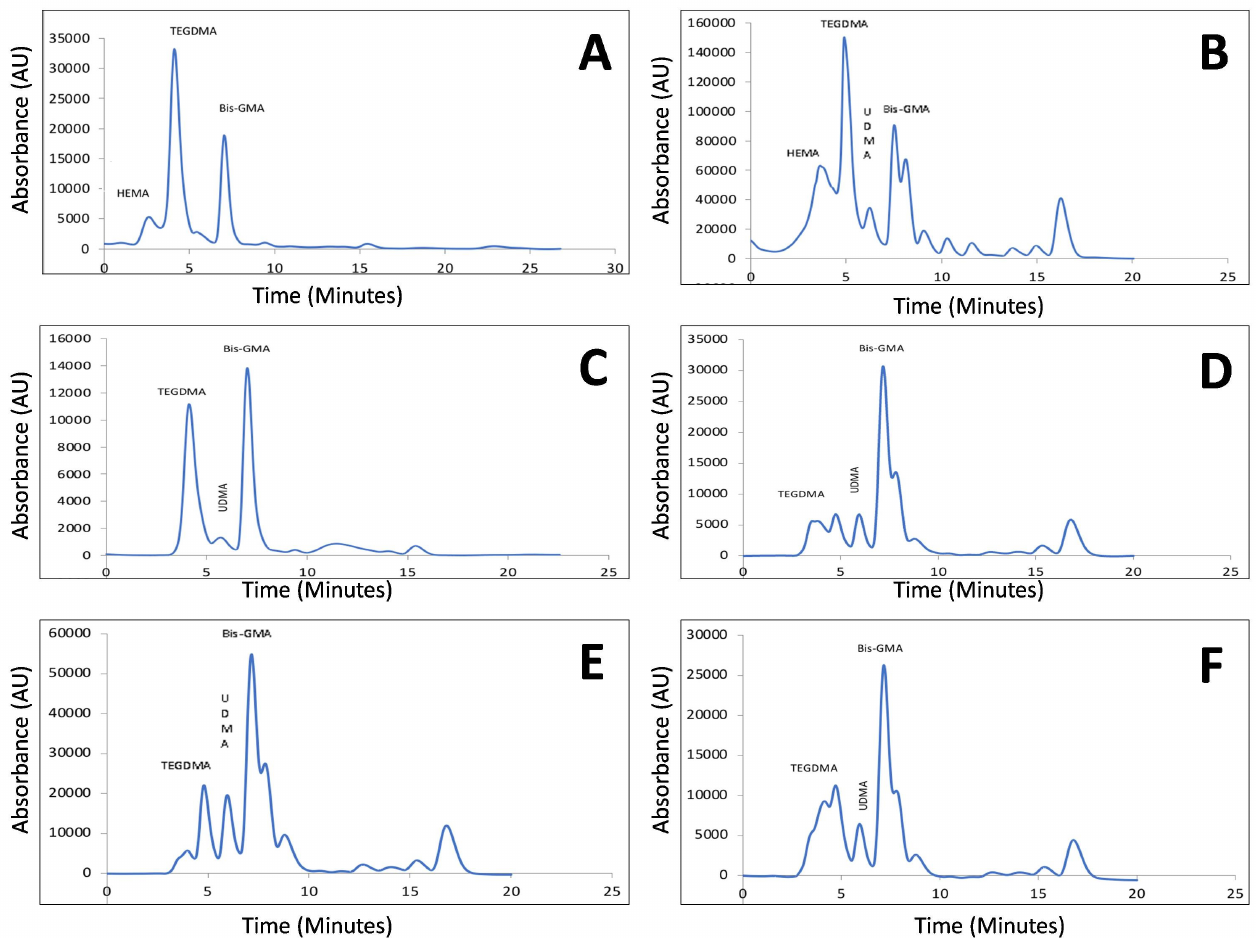
Figure 1. ( A – F ): Monomer Elution From Different Resin Composite At Two Different Time Interval Using High-Performance Liquid Chromatography ( A ) Ceram X composite Resin after 24 h; ( B ) Swiss Tech Resin Composite after 24 h; ( C ) Injectable Resin Composite after 24 h; ( D ) Ceram X Resin Composite after 7th day; ( E ) Swiss Tec after 7th day; ( F ) Injectable resin composite after 7th day.